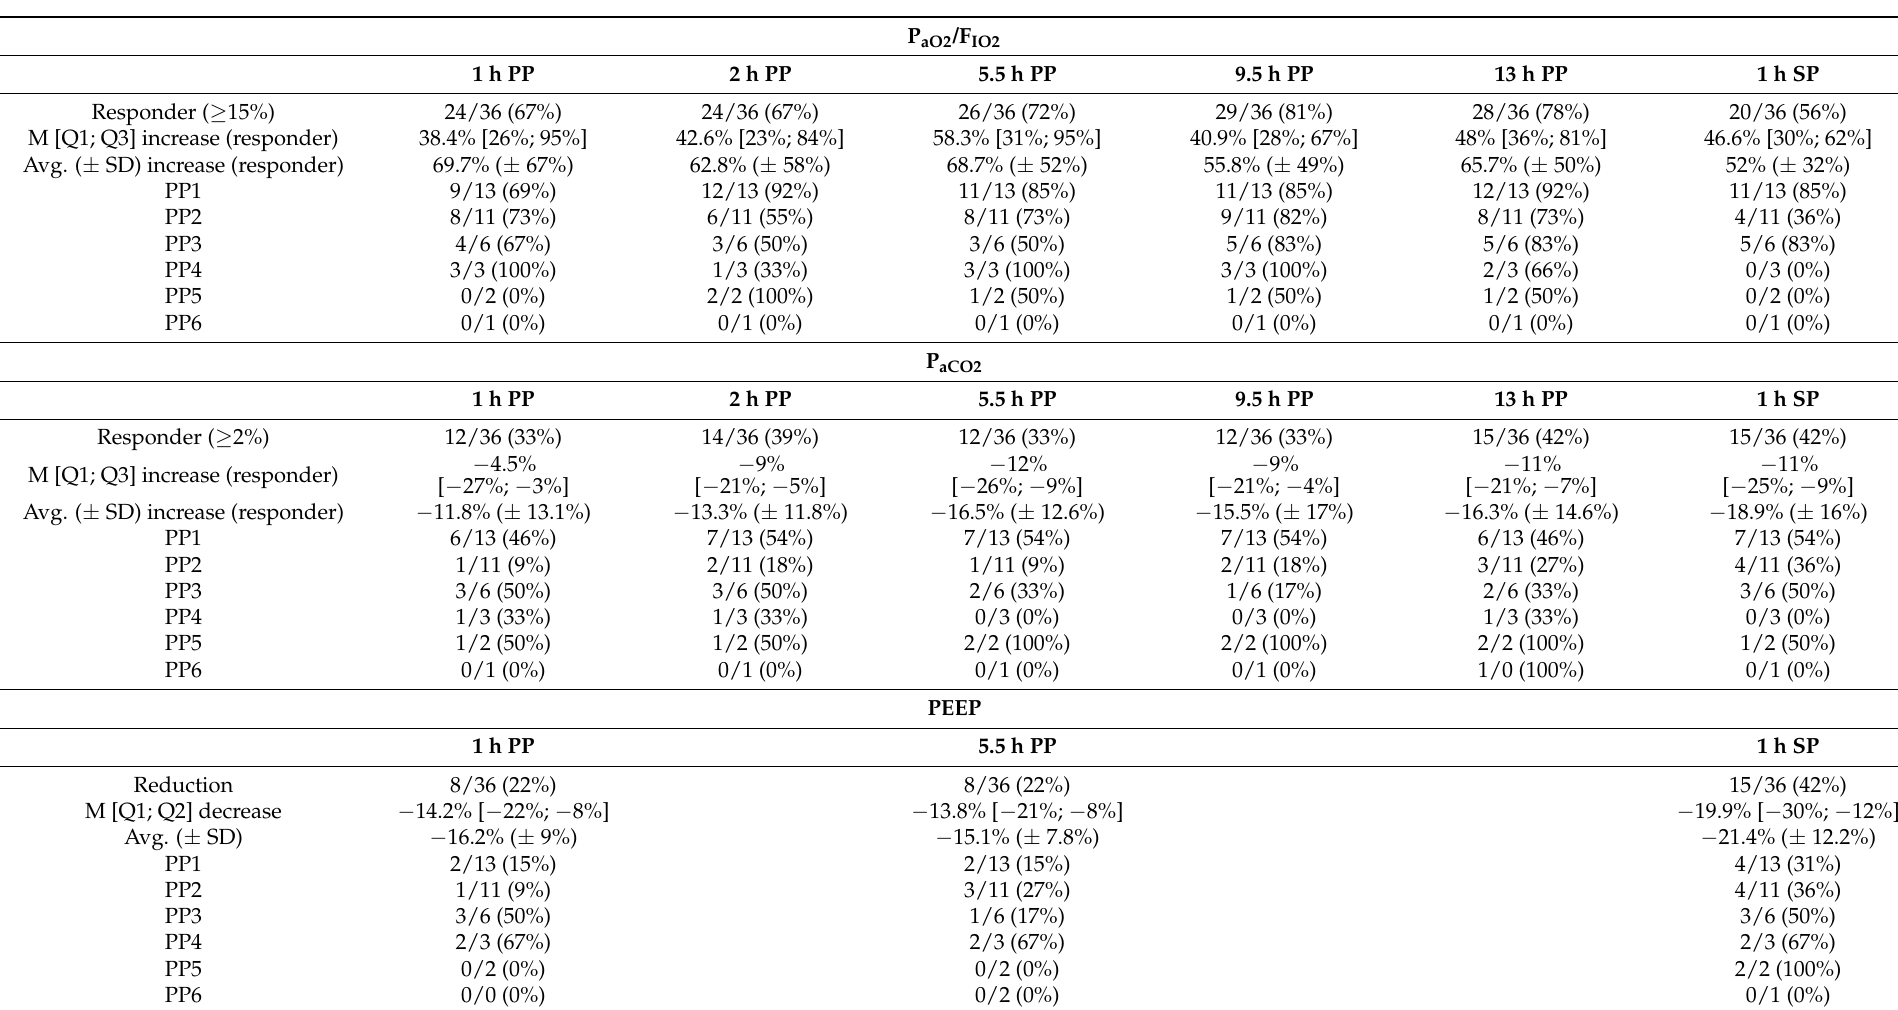
Table 3. Changes in the P aO2 /F IO2 ratio and P aCO2 in response to prone ventilation sessions, changes in the PEEP, P Max , and minute ventilation in response to prone ventilation